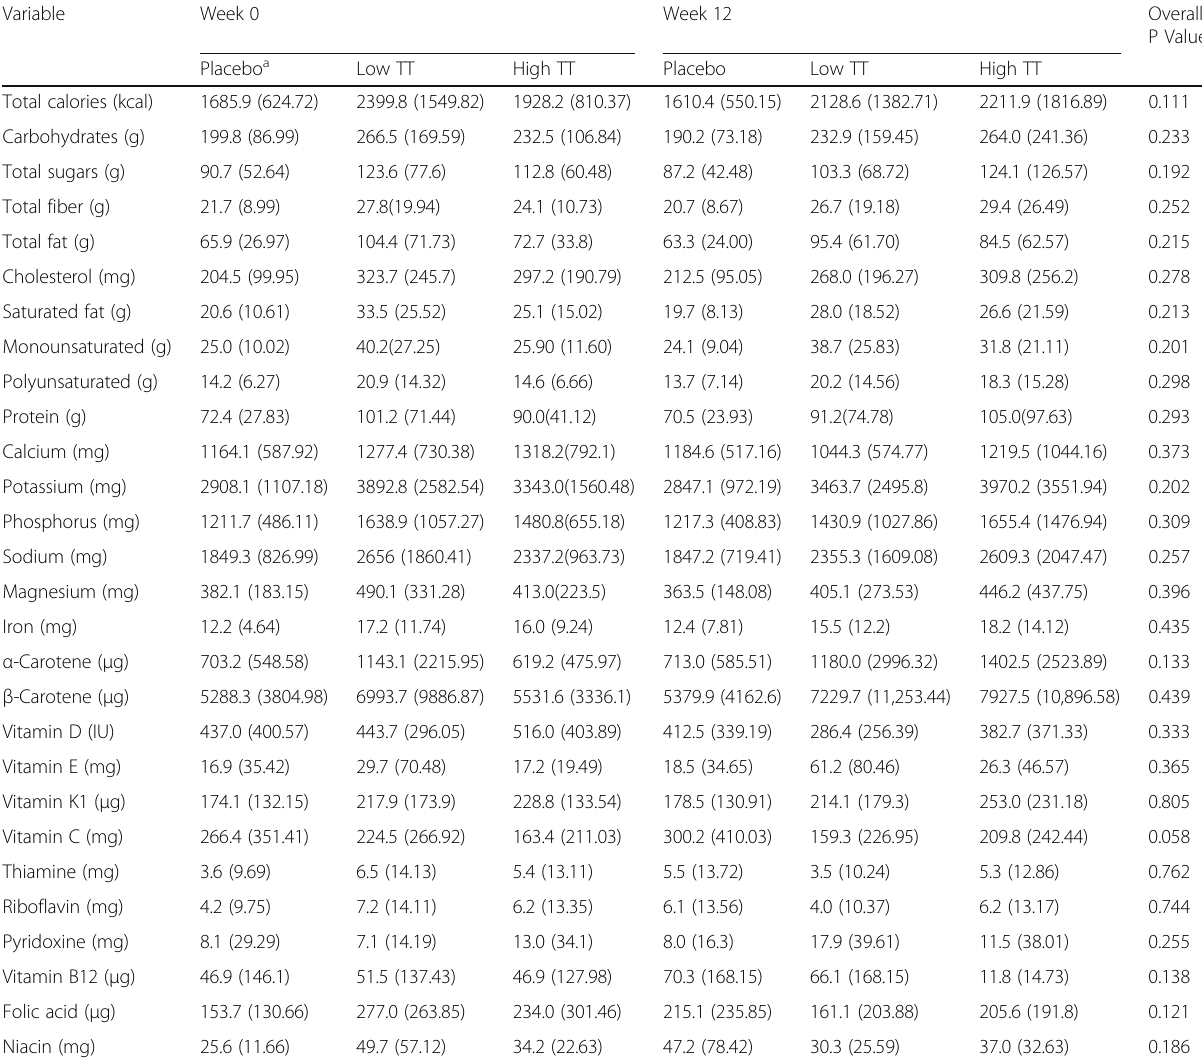
Table 6 Effect of tocotrienol supplementation on macro- and micro-nutrient intake in postmenopausal osteopenic women